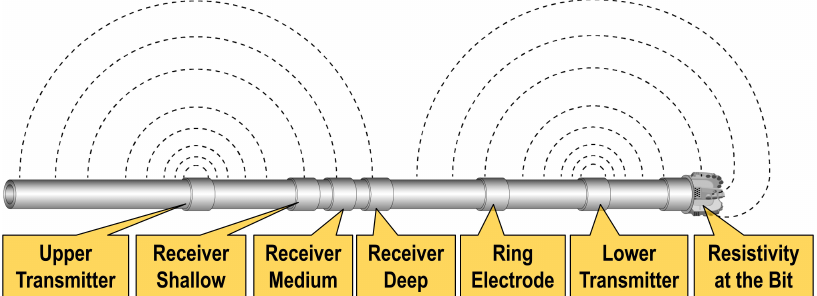
Figure 9. Resistivity at the bit tool schematic (based on